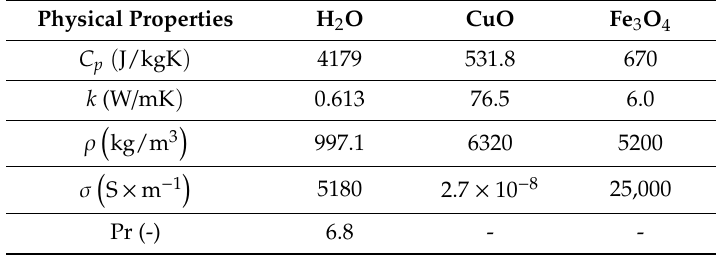
Table 2. Thermophysical properties of CuO, Fe 3 O 4 , and working fluid ( H 2 O )